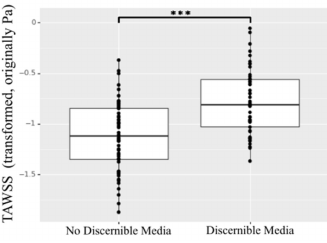
Figure 9. TAWSS for specimens showing no discernible media layer versus discernible media layer. *** indicates p value <